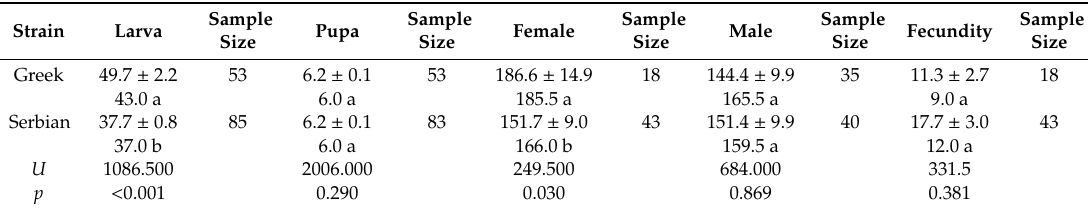
Table 1. Duration of immature development, female and male longevity in days (mean ± SE, median) and female fecundity (eggs / female) of two strains of Tribolium confusum (mean, 95% C.I.) fed on cracked barley. Medians within a column followed by the same letter are not statistically di ff erent (Mann–Whitney Rank Sum Test at a =